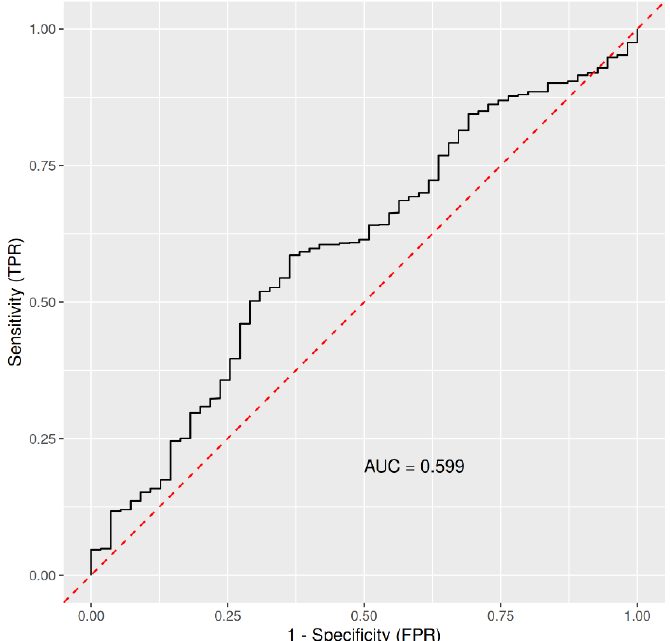
Figure 2. ROC based on the Out-Of-Bag data from imbalanced RandomForest, trained on 1130 controls (probands who were not infected with COVID-19) and 55 COVID-19 cases detected by RT-PCR, with the asymptomatic cases excluded, where frequency of inflammation of upper respiratory tract, weight, height, age, gender, being a cold-water swimmer, being a sportsman, and frequency of cold/ice water swimming were used as the predictors. Abbreviations: AUC, area under the curve; FPR, false positive rate; TPR, true positive rate.